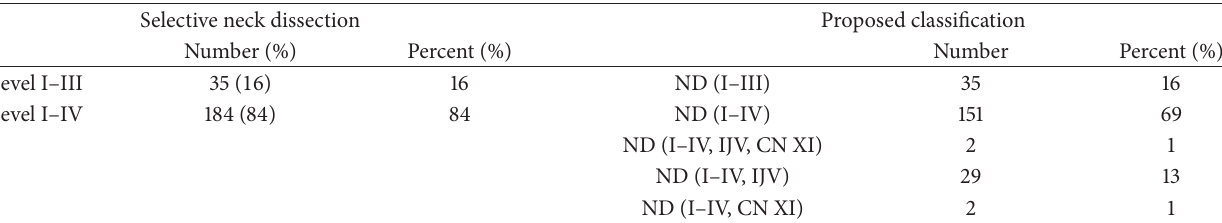
Table 3: Comparison of old and proposed